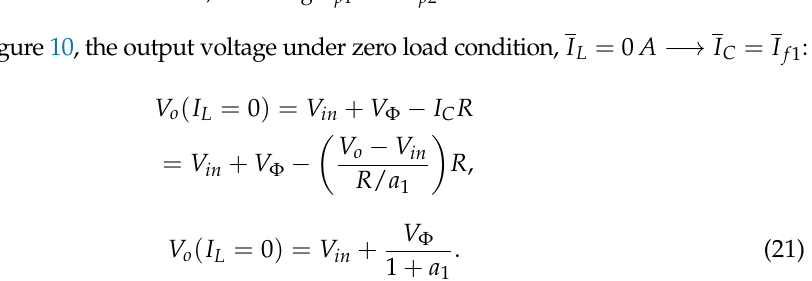
Figure 10. Analysis of the RN-P model, including C p 1 and C p 2